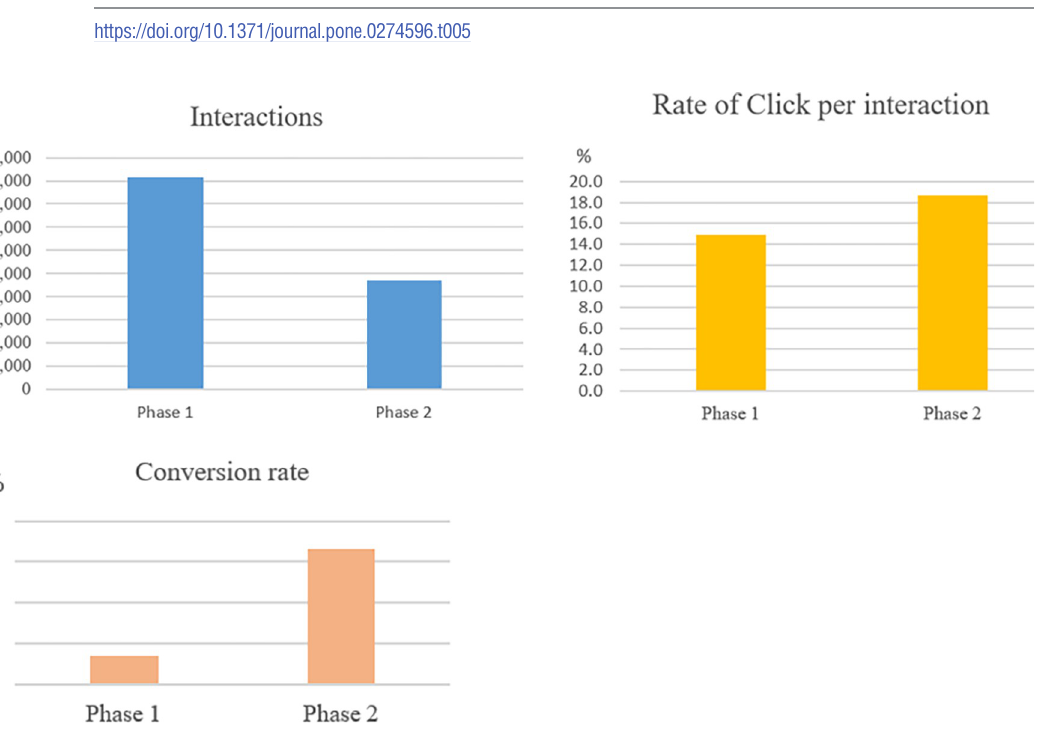
Fig 9. Compare the factors between the two phases.